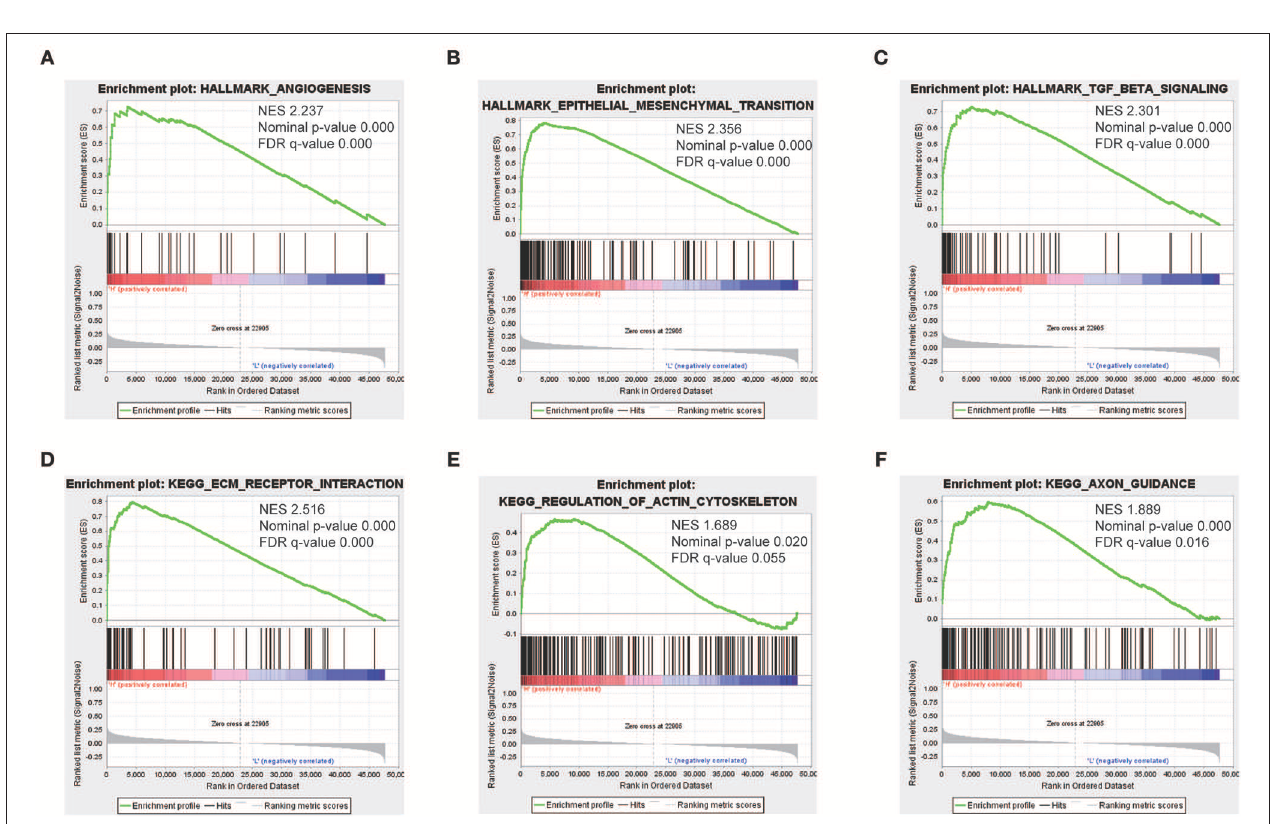
FIGURE 4 | Enrichment plots from gene set enrichment analysis (GSEA). GSEA results showing that “HALLMARK_ANGIOGENESIS” (A) , “HALLMARK_EPITHELIAL_MESENCHYMAL_TRANSITION” (B) , “HALLMARK_TGF_BETA_SIGNALING” (C) , “KEGG_ECM_RECEPTOR_INTERACTION” (D)